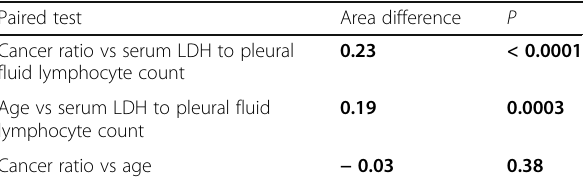
Table 4 Comparison between AUC of each predictor Paired test